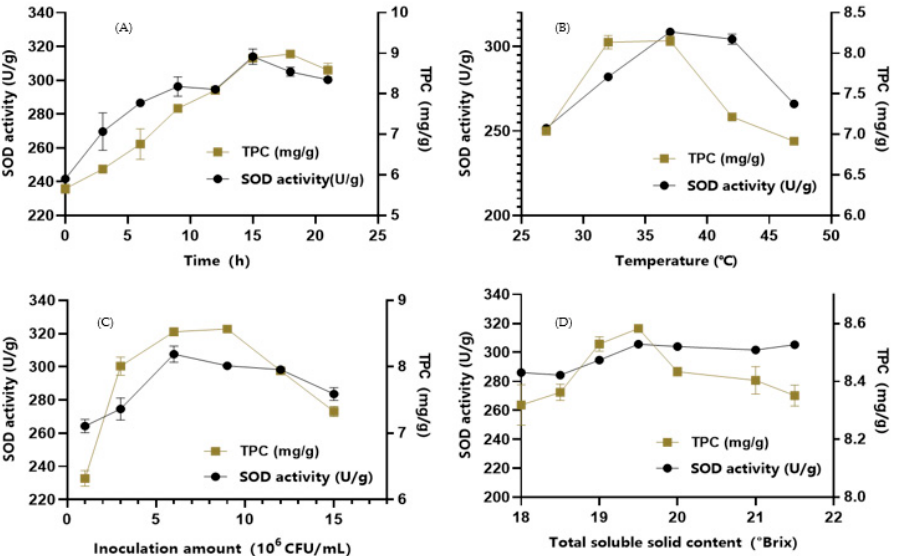
Figure 1. Subfigures ( A–D ) show the influence of fermentation time, temperature, inoculum con- centration, and total soluble solid content of FMBJ.